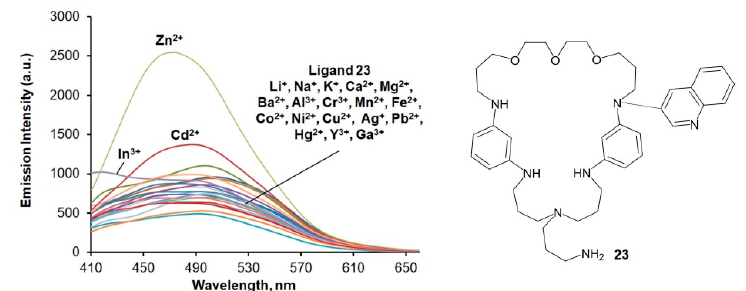
Figure 6. Spectra of the fluorescence of compound 23 in the presence of Li(I), Na(I), K(I), Mg(II), Ca(II), Ba(II), Al(III), Cr(III), Mn(II), Fe(II), Co(II), Ni(II), Cu(II), Zn(II), Cd(II), Hg(II), Pb(II), Ag(I), Ga(III), In(III) and Y(III) (five equiv.). C L 21.2 μ M, λ ex 370 nm.